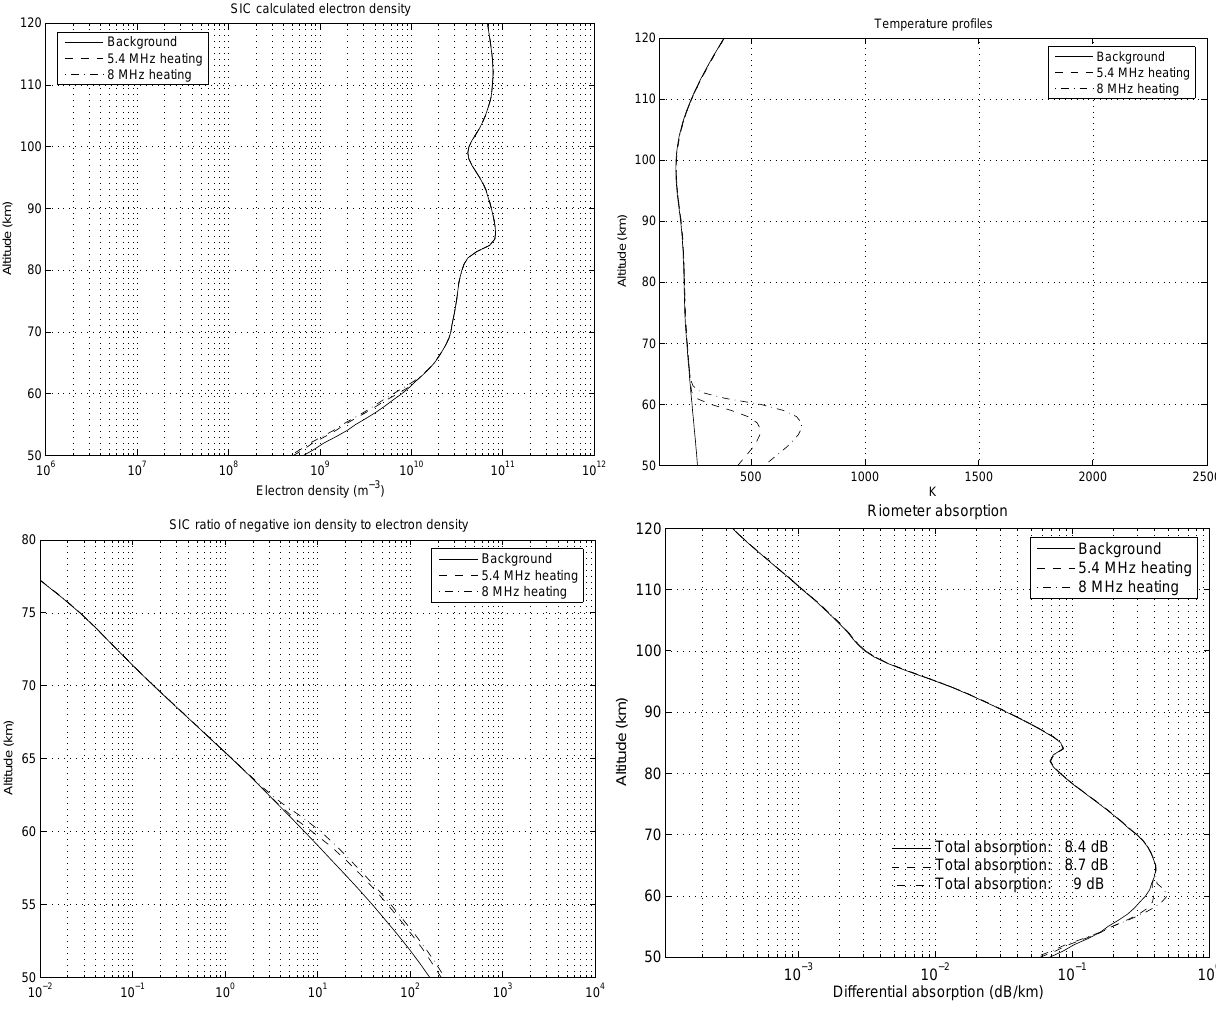
Fig. 5. The proton precipitation noon case, altitude profiles at the end of the heating interval (12:55 UT) for the background run and the two heating cases of 0.6GW ERP at 5.4 MHz and 1.2GW ERP at 8 MHz. Plot 1: SIC modelled electron density; Plot 2: Electron temperatures; Plot 3: The ratio of negative ion density to electron density (NOTE: this is only shown for altitudes up to 80km); Plot 4: The calculated cosmic noise absorption at 38.2MHz as observed by a narrow riometer beam tilted by 45 ◦